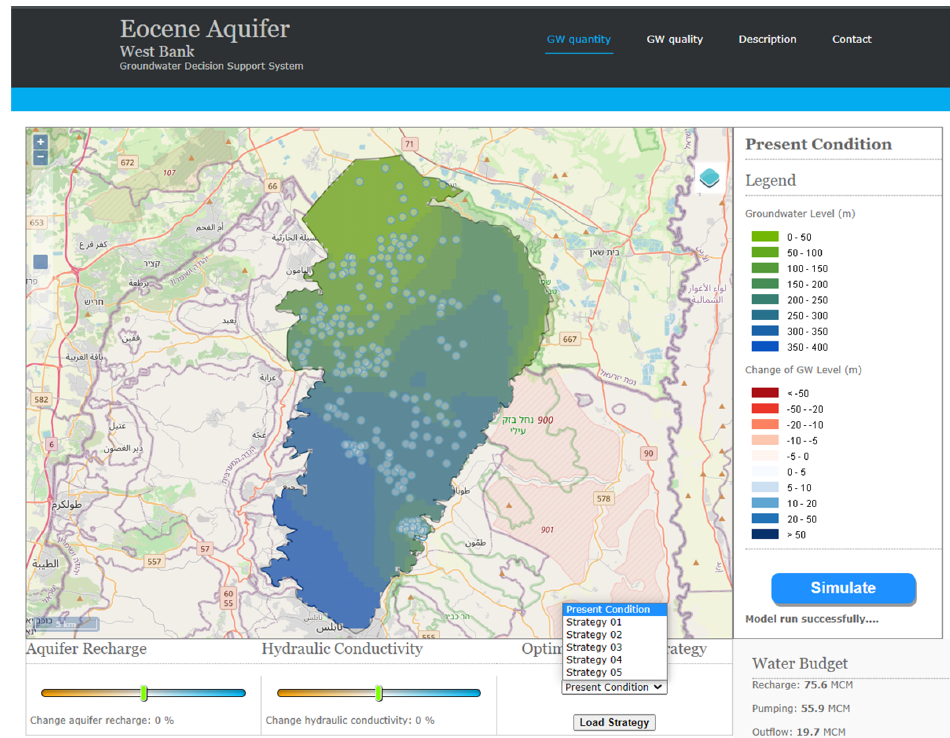
Figure 28. Main user interface of GDSS for the groundwater quantity component—results of a model run for the present condition. (Note: place names in background Open Street map are denoted in Arabic language, same for Figures 29–32).